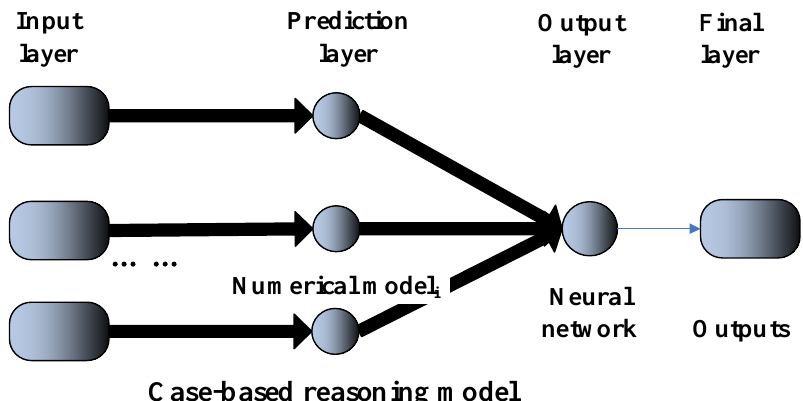
Figure 6. Neural network-based data assimilation system.